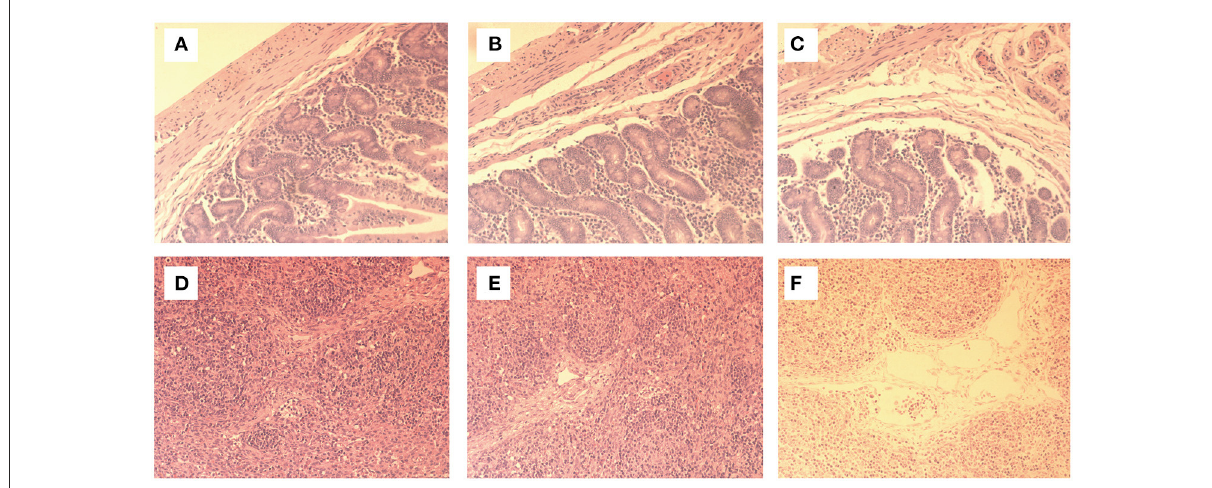
FIGURE2 On the 7th day of the experiment, the intestines and mesenteric lymph nodes of the piglets were sectioned and fixed and made into tissue sections for observation. Histopathological examination showed that the morphology of group B was normal and neatly arranged, with intestinal villi, goblet cells and other structures clearly visible (A) . The morphology of lymph nodes was normal, without histopathological changes (D) . In group A1, the intestinal villi were slightly damaged and the other structures were normal (B) . Some lymph node cells were enlarged (E) . There were no obvious pathological changes in A2 and A3 groups. In group C, intestinal villi were broken, atrophic and shortened, and some intestinal villi were damaged. Some intestinal epithelial cells were necrotic and exocytic, accompanied by inflammatory cell infiltration (C) , increased inflammatory cells in lymph nodes, and tissue edema (F)